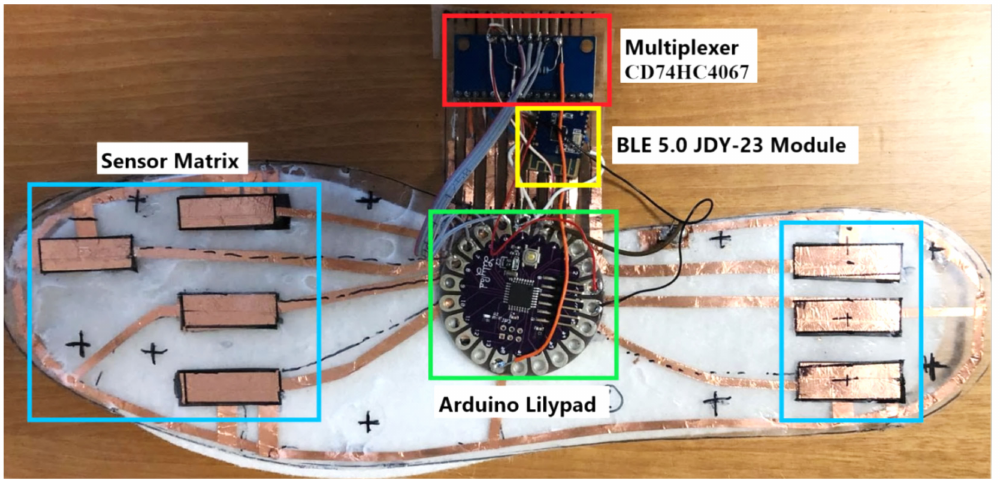
Figure 22. Top view of smart insole prototype constituted by the piezoresistive sensing matrix, acquisition, and communica- tion